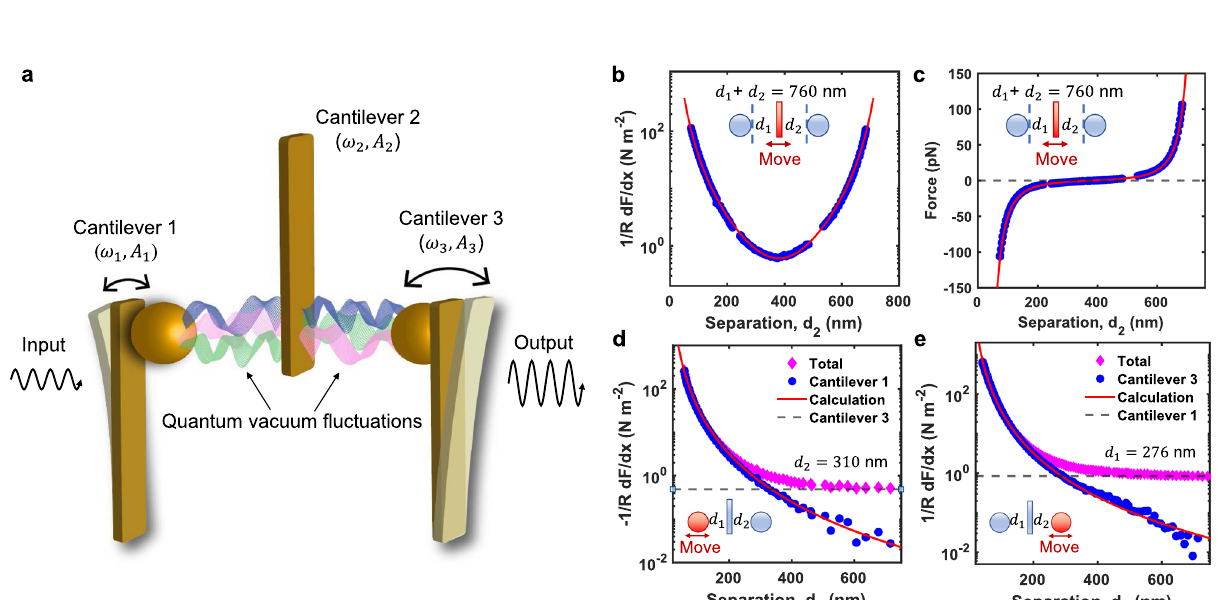
Fig. 1 | Casimir interaction between three optomechanical resonators. a Three modi fi ed cantilevers with resonant frequencies ω 1 , ω 2 and ω 3 experience Casimir force between each two nearby surfaces. The vibration amplitudes of three canti- leversare denoted as A 1 , A 2 and A 3 . Additionalparametric modulations are applied onthecentercantilevertocouplethembytheCasimireffect.Wecanswitchonand off the Casimir coupling between cantilever 1 and cantilever 3 by controlling the parametric modulations. In addition, we can amplify the energy transfer through Casimir effect by adding an extra gain to cantilever 2. b Measured Casimir force gradient on cantilever 2 (center) as a function of its position when the other two surfaces are fi xed such that d 1 + d 2 =760nm. The blue circles are experimental